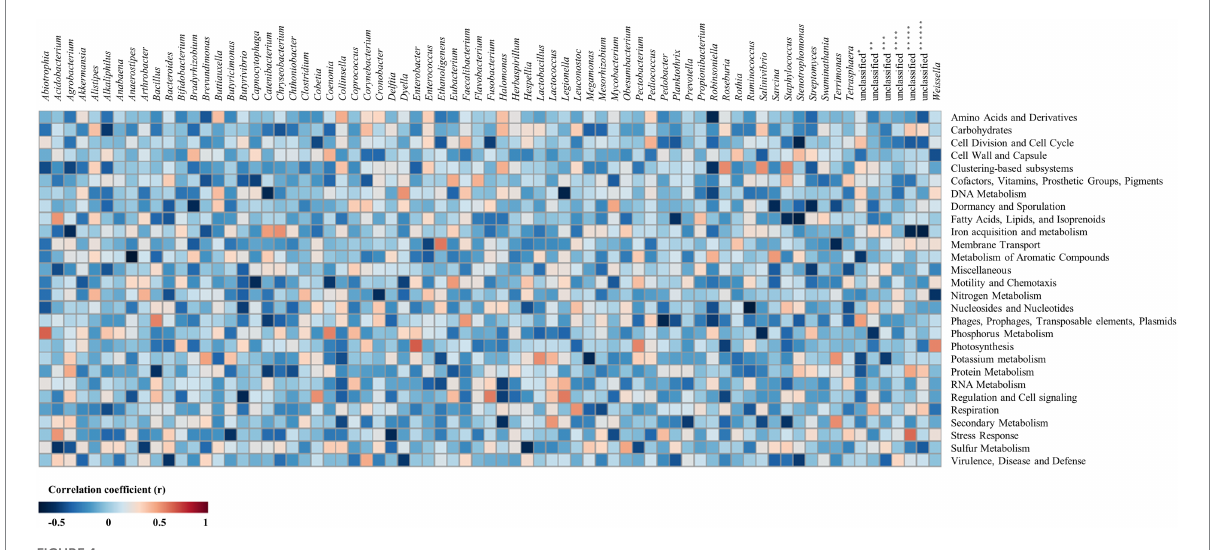
FIGURE 4 Heatmap for correlation between metataxonome and metatranscriptome. The metataxonome was at the genus level, and the metatranscriptome was at level 1. The re-sampling by bootstrapping was performed 20 times. * , unclassified bacteria; ** , unclassified bacteria derived from Betaproteobacteria ; *** , unclassified bacteria derived from Clostridiales ; **** , unclassified bacteria derived from Erysipelotrichaceae ; ***** , unclassified bacteria derived from Gammaproteobacteria ; ****** , unclassified bacteria derived from Verrucomicrobia subdivision